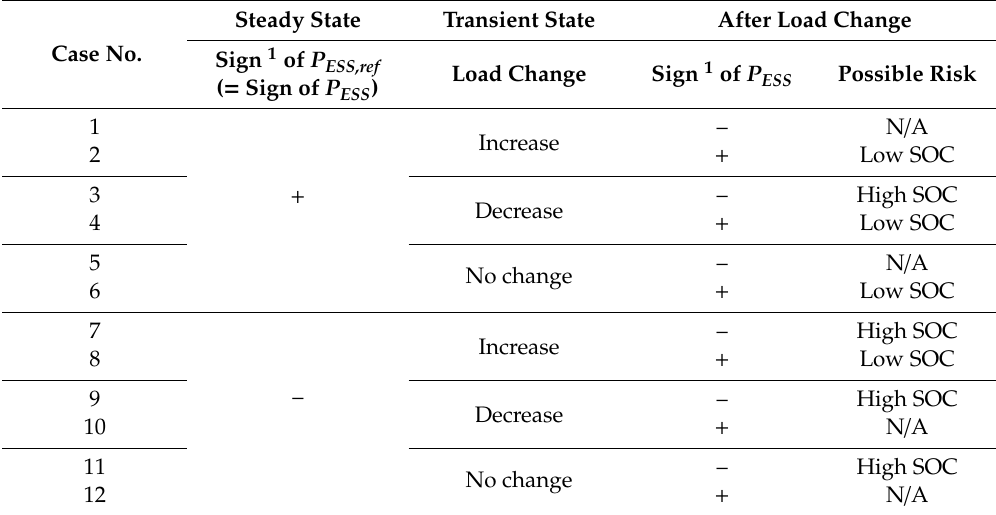
Table 1. All possible cases of state-of-charge (SOC)